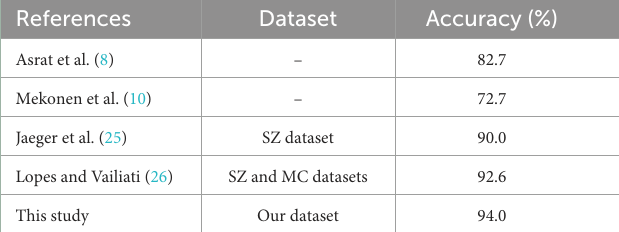
TABLE 8 Comparison of proposed method with existing